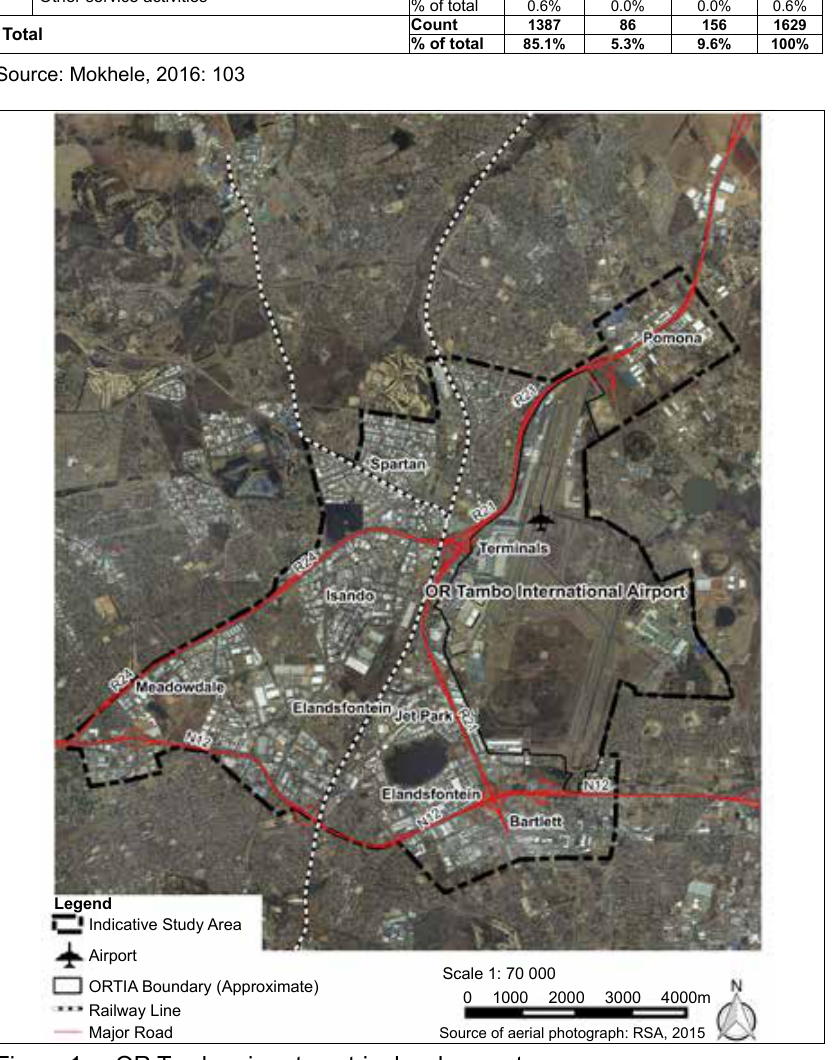
Source of aerial photograph: RSA, 2015